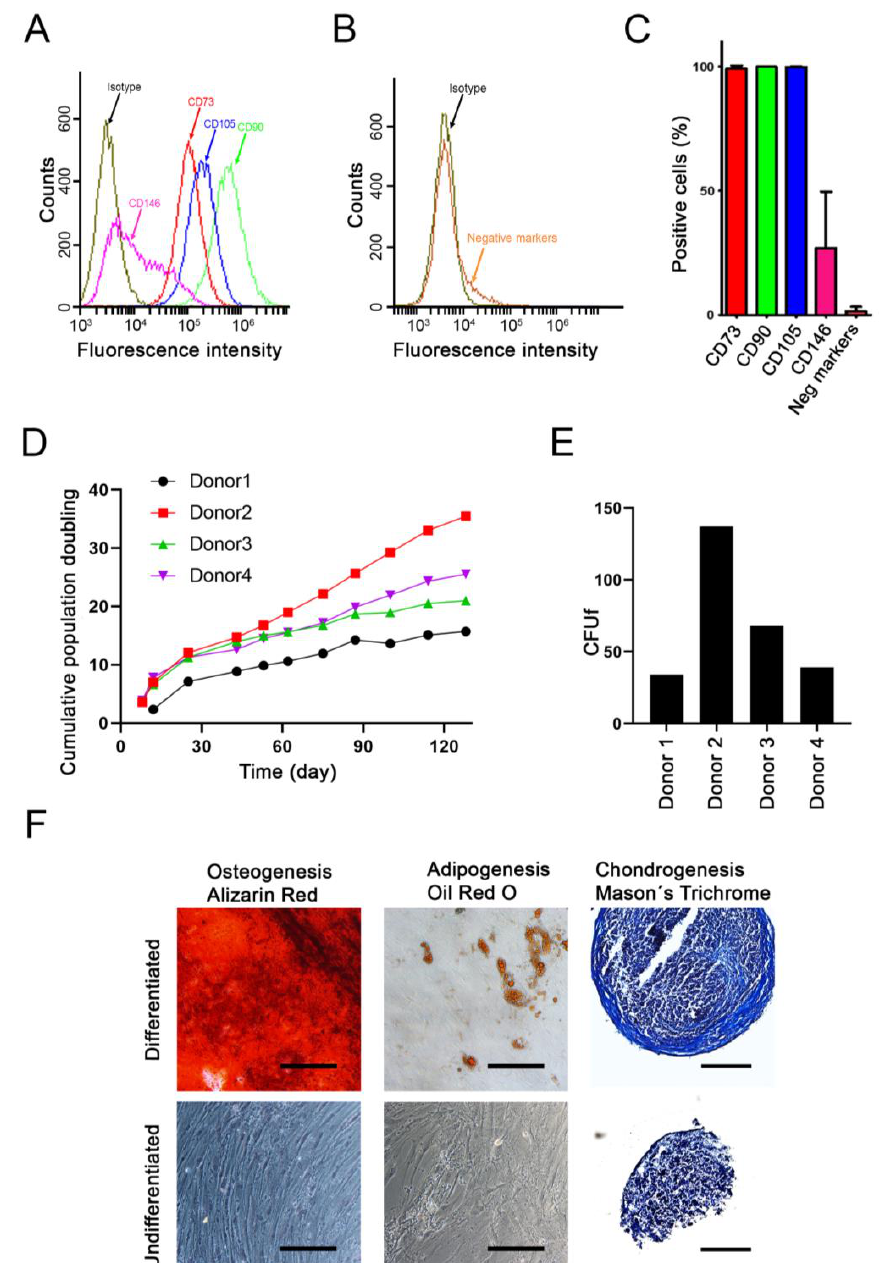
Figure 1. Characterization of donor MSCs. ( A – C ) Flow cytometry characterization of positive- and negative-associated CD markers. ( A ) A representative donor overlay plot is shown for the expression of positive markers: CD73, CD90, CD105 and CD146, in relation to the isotype control. ( B ) A representative donor overlay plot is shown for the expression of negative markers CD11b, CD19, CD34, CD45 and HLA-DR, in relation to the isotype control. ( C ) Quantification of the expression of positive and negative CD markers (mean + SD, n = 4). ( D ) Cumulative population doubling assessed for each of the donor cells for a total of 128 days. ( E ) Colony forming unit fibroblastic (CFUf) was determined after two weeks of culture with the starting density of 300 cells in a T25 flask. ( F ) Undifferentiated and differentiated cells from a representative donor are shown. Different staining was used to confirm the differentiation of the cells: for osteogenesis (5 weeks, Alizarin red), for adipogenesis (4 weeks, Oil red O), and for chondrogenesis (5 weeks, Masson’s trichrome). Scale bar = 200 µ